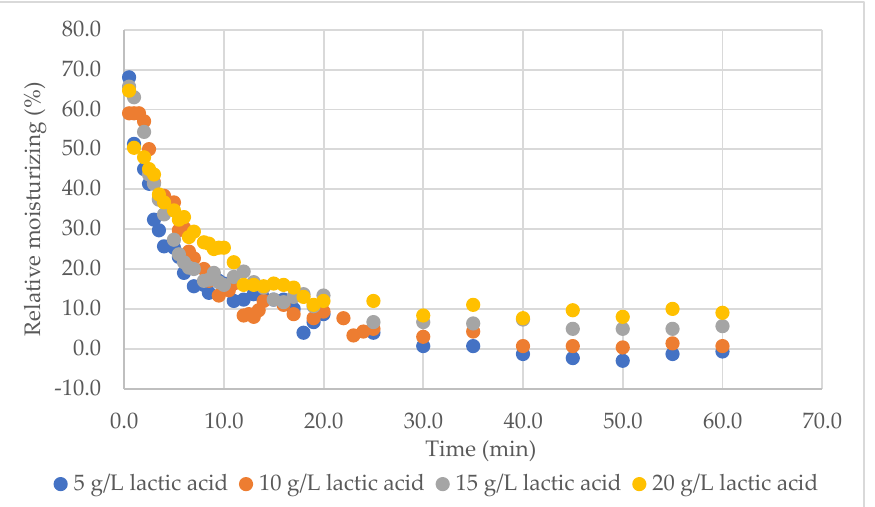
Figure 2. Moisturising effects of lactic acid solutions versus time. The results obtained in the 35th, 40th, 45th, and 50th minutes were averaged and plotted against the lactic acid concentration (Figure 3). A trendline was fitted to the obtained points, which we were able to use to predict the hydrating effect of the fermentation filtrates according to their lactic acid concentrations.